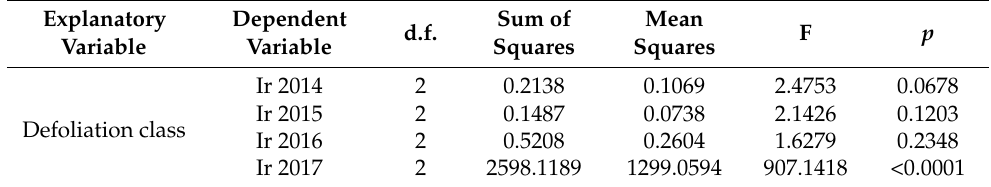
Table 2. Summary statistics for differences between annual radial growths depending on the defolia- tion class (repeated measures